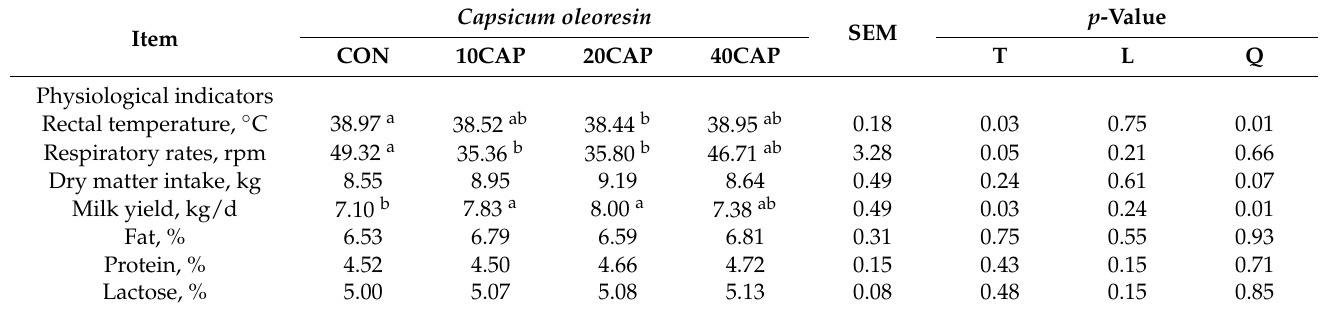
Table 4. Physiological indicators, dry matter intake, and milk performance as affected by Capsicum oleoresin (CAP)